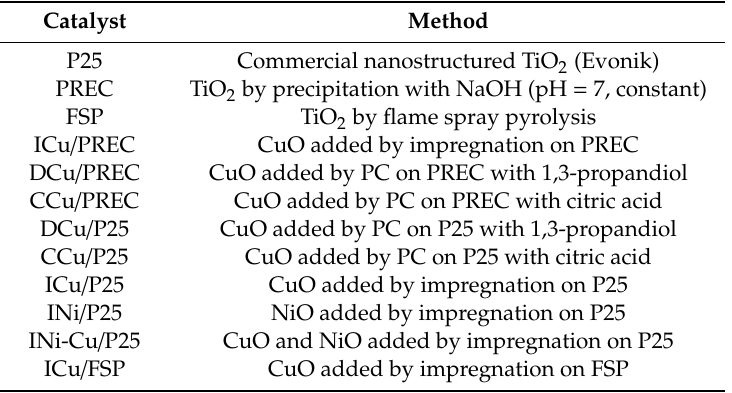
Table 4. Catalysts and their related chemical